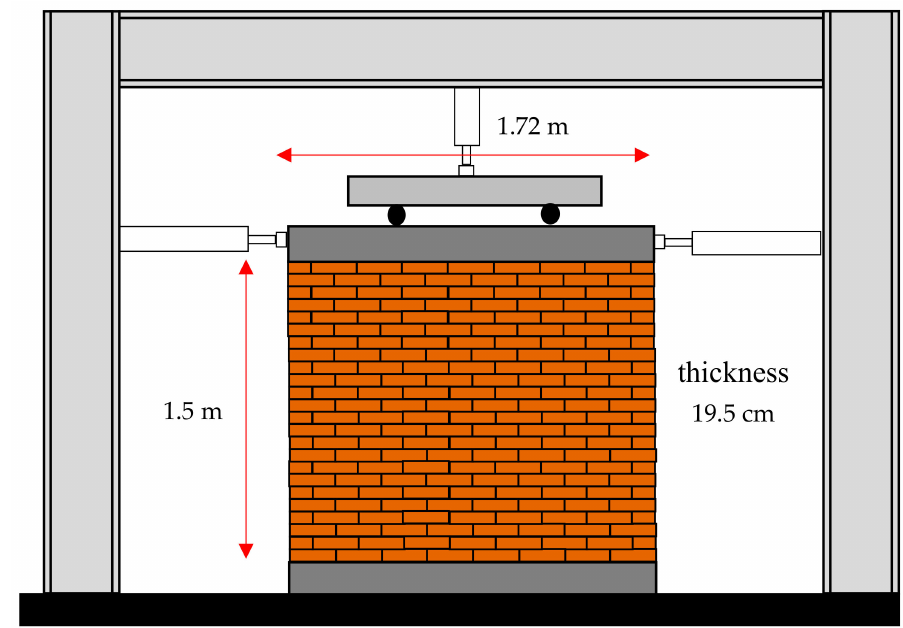
Figure 3. Dimension of experimental masonry